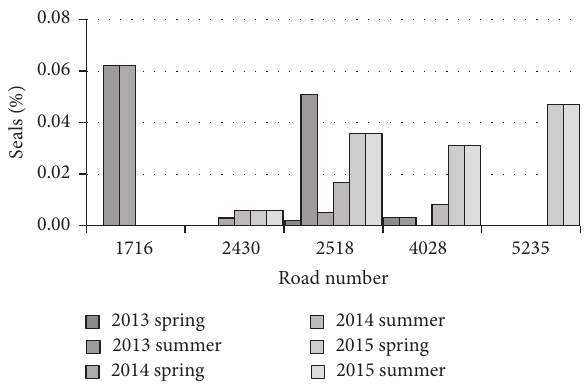
Figure 10: Seals on roads sections covered with soft